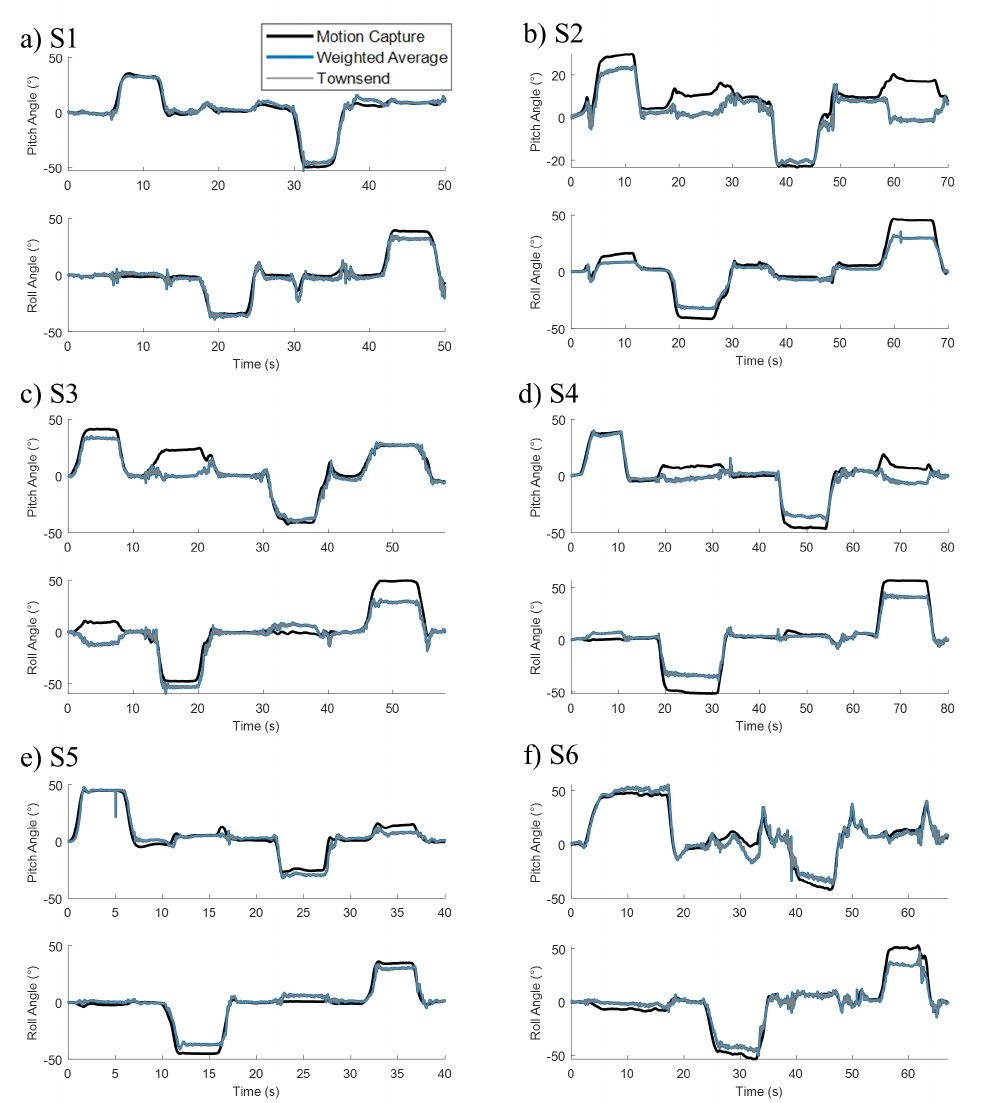
Figure 7. Pitch and roll angles from all subjects S1 ( a ), S2 ( b ), S3 ( c ), S4 ( d ), S5 ( e ), and S6 ( f ) determined through sensor fusion optimized with motion